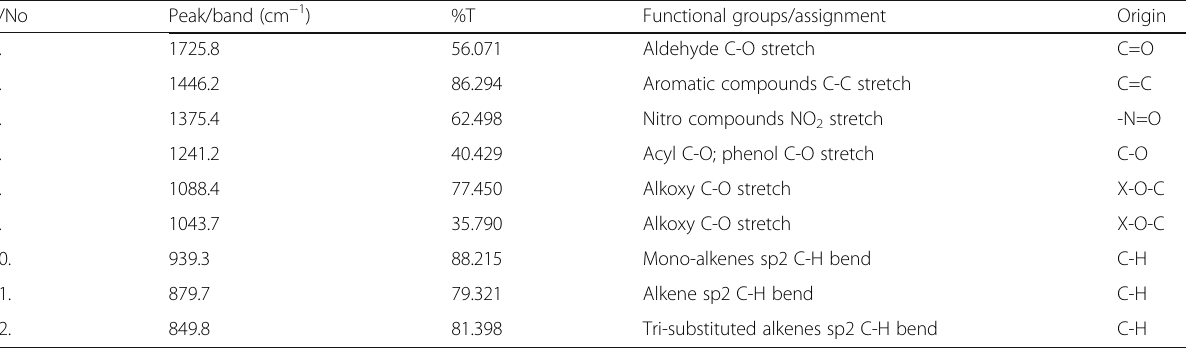
Table 5 FT-IR spectra peak values of (A) petroleum ether extract of A . occidentale , (B) ethylacetate extract of A . occidentale , (C) n - hexane extract of P . guajava , (D) chloroform extract of P . guajava , (E) ethylacetate extract of P . guajava , and (F) ethylacetate extract of T . catappa